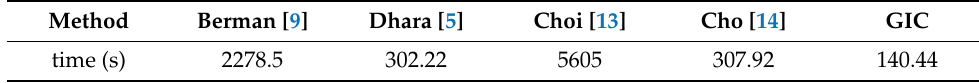
Table 3. The efficiency of candidate dehazing